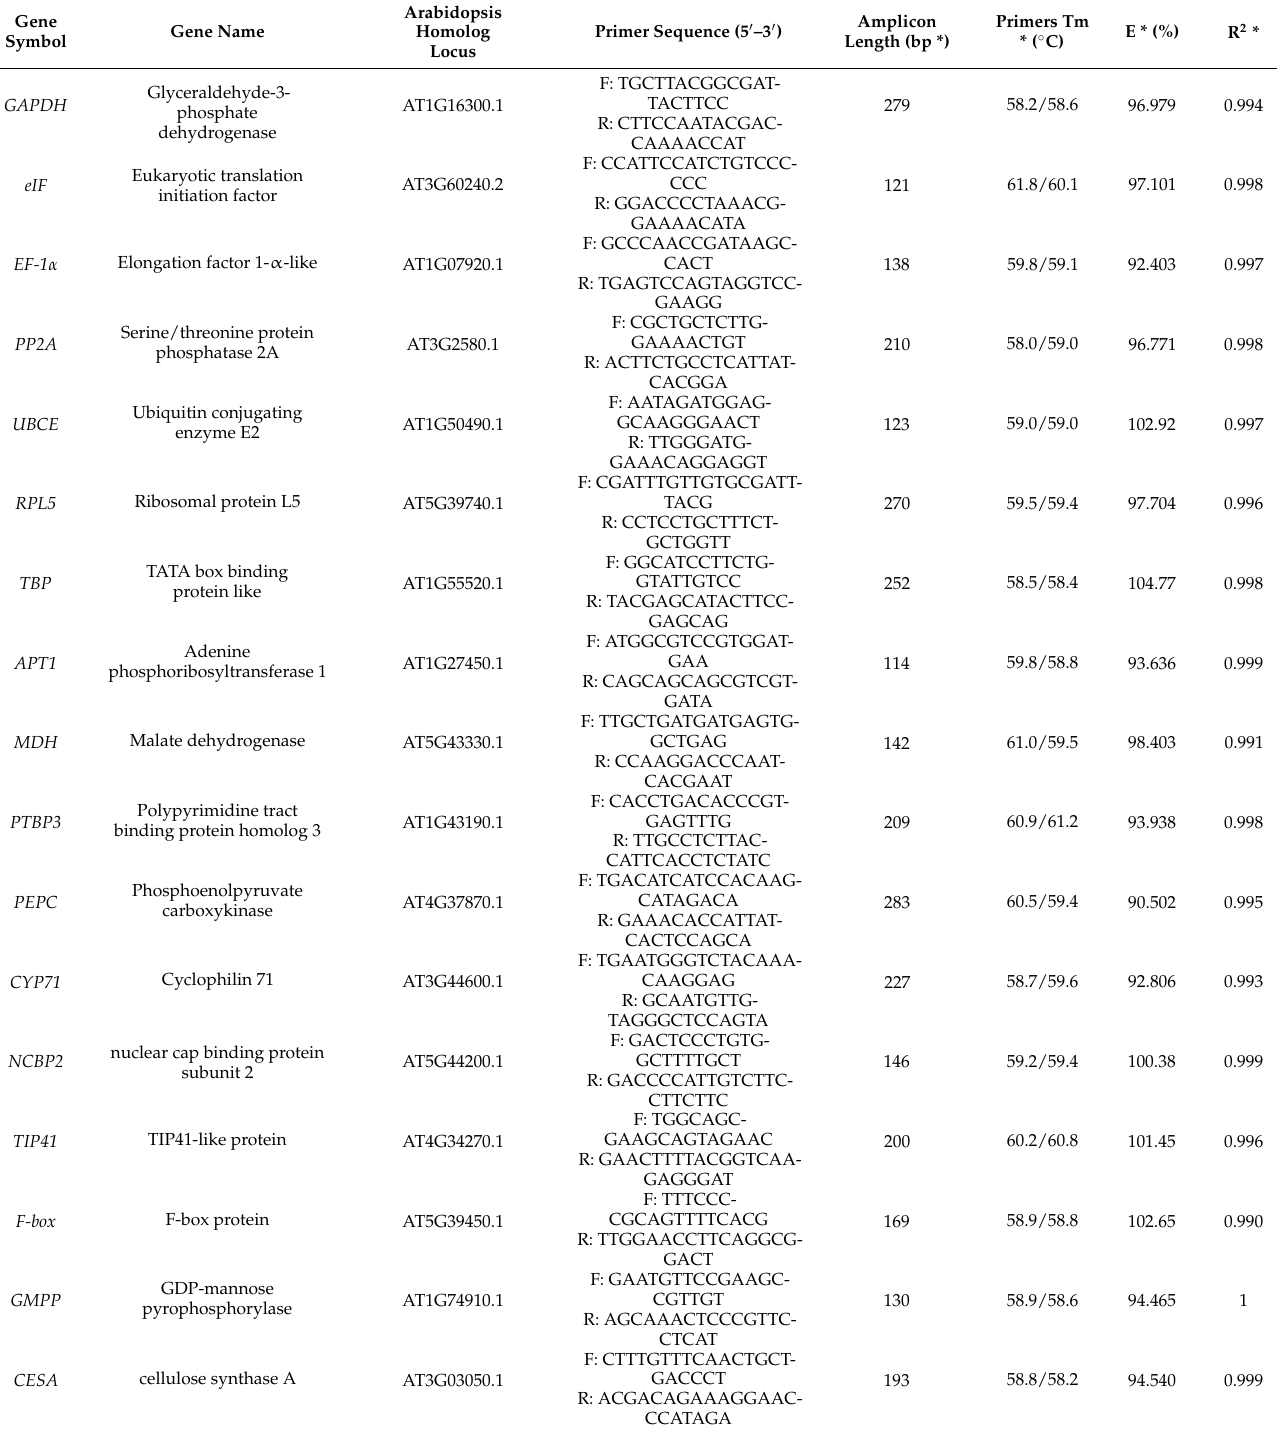
Table 1. Candidate genes and primer pairs used for qPCR normalization in D. huoshanense